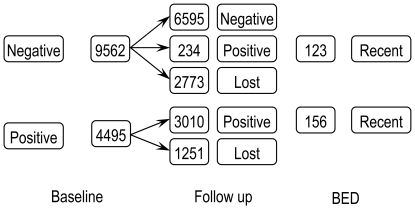
Summary of baseline and 12-month postpartum HIV results and, for the latter, of the BED results for HIV positive cases.